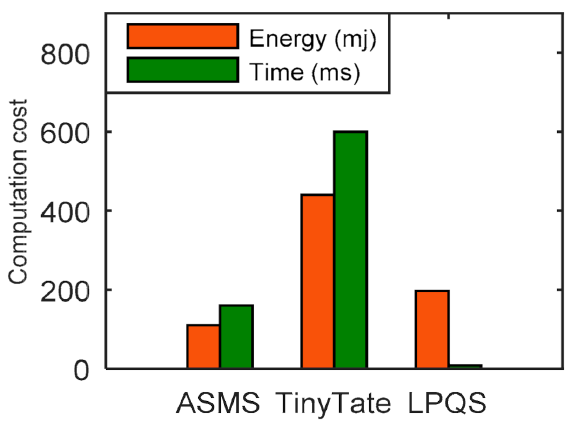
Figure 4. Computation cost of nonqunatum techniques for energy and time